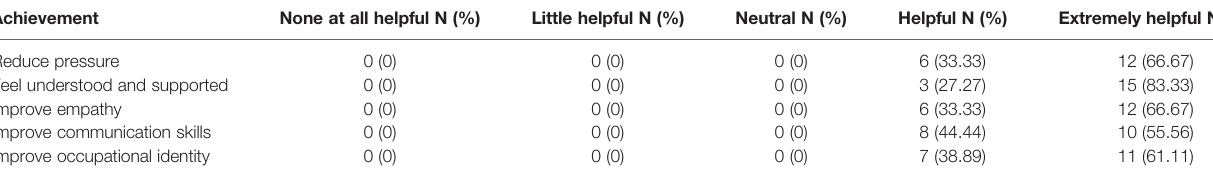
TABLE 5 | Participants' achievements after intervention in Balint groups (n = 18). Achievement None at all helpful N (%)